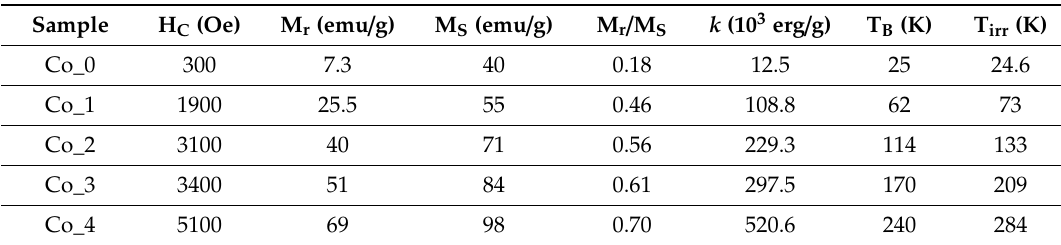
Table 3. Coercivity (H C ), remanent magnetization (M r ), saturation magnetization (M S ), squareness ratio (M r / M S ), anisotropy constant ( k ), blocking temperature (T B ) and irreversibility temperature (T irr ) of Co x Zn 1-x Fe 2 O 4 ferrite